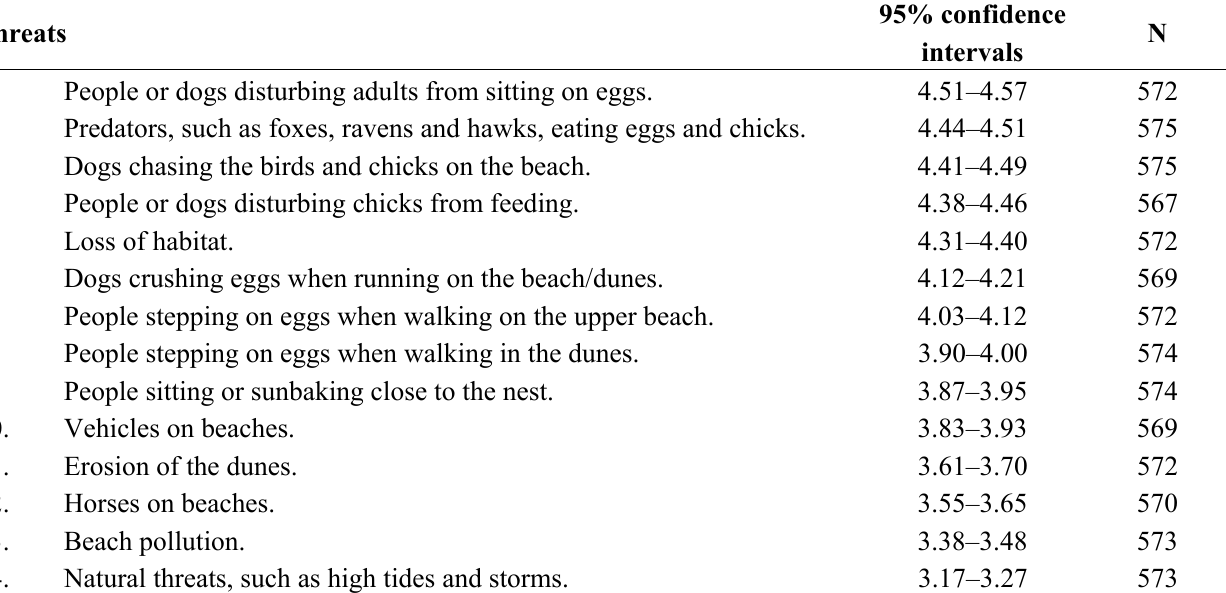
Table 3. Respondent ratings of the seriousness of 14 known threats to the Hooded Plover (descending order of importance, where 5 is “serious” and 1 “not serious”). Ninety-five percent confidence intervals are presented.